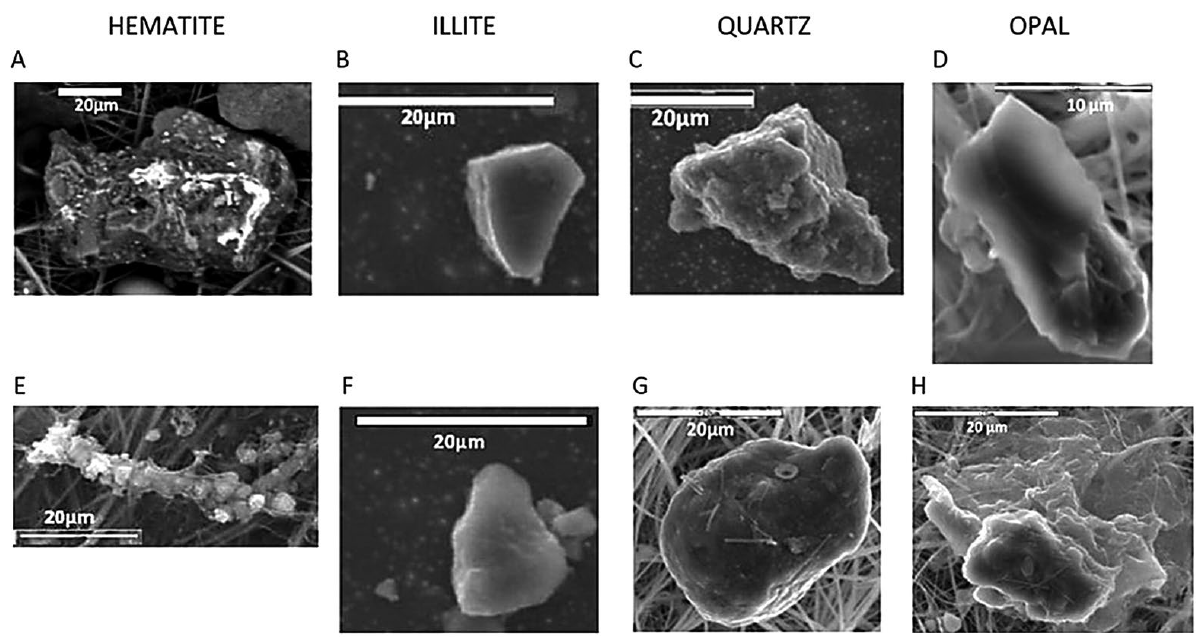
Fig. 9. – Electron microscope (SEM-EDX) images; A and B are incrusted iron oxide (white patches) in a transparent organic material; C and D are laminar structures of illite; E and F are granular structures of quartz; G is a biological structure composed of opal; H is a laminar structure composed of